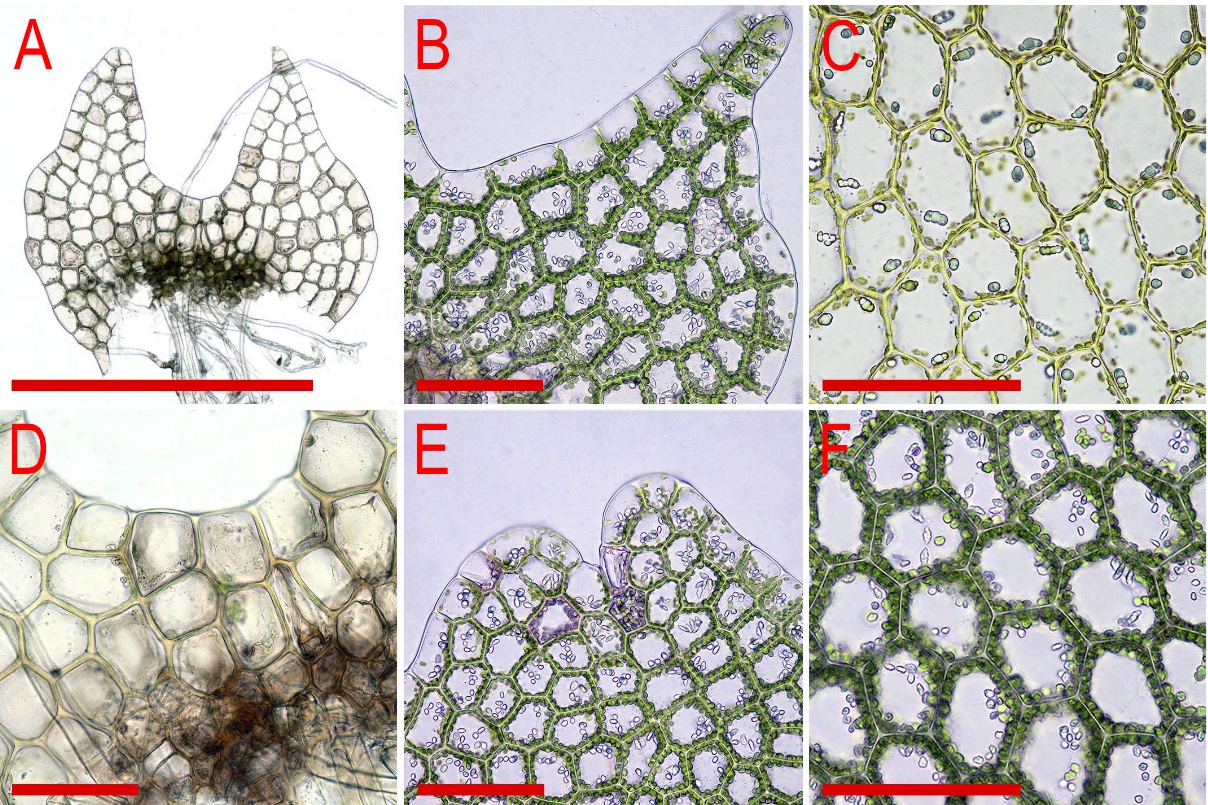
Figure 21. Calypogeia kamchatica Bakalin, Troizk. et Maltseva, sp. nov. : ( A ) Underleaf; ( B ) Underleaf lobe cells with oil bodies; ( C , F ) Midleaf cells with oil bodies; ( D ) Cells in underleaf sinus; ( E ) Leaf apex cells with oil bodies. Scales: 500 µ m for ( A ); 100 µ m for ( B , C , E , F ). ( A , D ) From K-58-7-18; ( B , E , F ) From Kh-38-7-19; ( C ) From K-63-4-15. All from VBGI. Calypogeia fissa (L.) Raddi, Jungermanniogr. Etrusca 33, 1818. Basionym: Mnium fissum L., Species Plantarum 1114, 1753. Description (based on studied specimens). Plants are in loose mats, pale greenish to greenish brownish in herbarium, somewhat glistening, prostrate, loosely attached to the substratum, 1.5–3.3 mm wide and 15–30 mm long. Rhizoids a few to abundant, obliquely to erect spreading, brownish, separated or in unclear fascicles. Stem cross section transversely ellipsoidal, in well-developed plants ca. 180 × 370 µ m, cell walls thin, but in the ventral side cell walls commonly thickened in two rows, outer cells the same size with inner or slightly smaller, 20–32 µ m in diameter, inner cells to 38 × 48 µ m, trigones very small. Leaves obliquely inserted, not decurrent in both sides, contiguous to subimbricate, nearly plane to slightly convex, sometimes with apex turned ventrally, when flattened in the slide obliquely ovate, 600–1500 × 600–1300 µ m, slightly longer than wider, apex obtuse to rarely short bifid. Underleaves obliquely spreading, commonly decurrent for 1/4 of stem width when looking in alive material, in the slide transversely ellipsoidal, 220–300 × 350–650 µ m, divided by U- to V-shaped sinus in to two acute lobes, additional lateral teeth common, blunt to acute, sometimes the same length with main lobe and then underleaves bisbifid. Midleaf cells are thin-walled, with small concave trigones, oblong, 50–85 × 45–63 µ m; along margin 38–80 × 30–50 µ m, thin-walled, with concave small trigones, trigones adjacent to external side sometimes concave. Specimen examined: Georgia, Adjara, Mtirala National Park, upper course of Chakvis- tavi River, ca. 4 km upstream of Chakvistavi Village (41 ◦ 40 (cid:48) 30.1 (cid:48)(cid:48) N 41 ◦ 52 (cid:48) 58.1 (cid:48)(cid:48) E) 400 m a.s.l., broadleaved Colchis forest in the stream valley, cliffs in part shade, 12 May 2013, V.A. Bakalin G-12-55-13